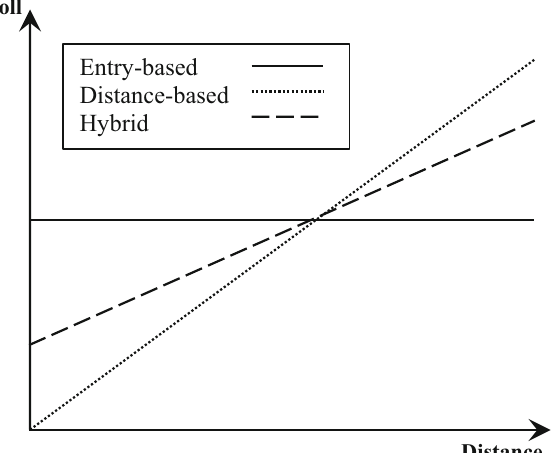
Fig. 1 Schematic designs of entry-based, distance-based and joint